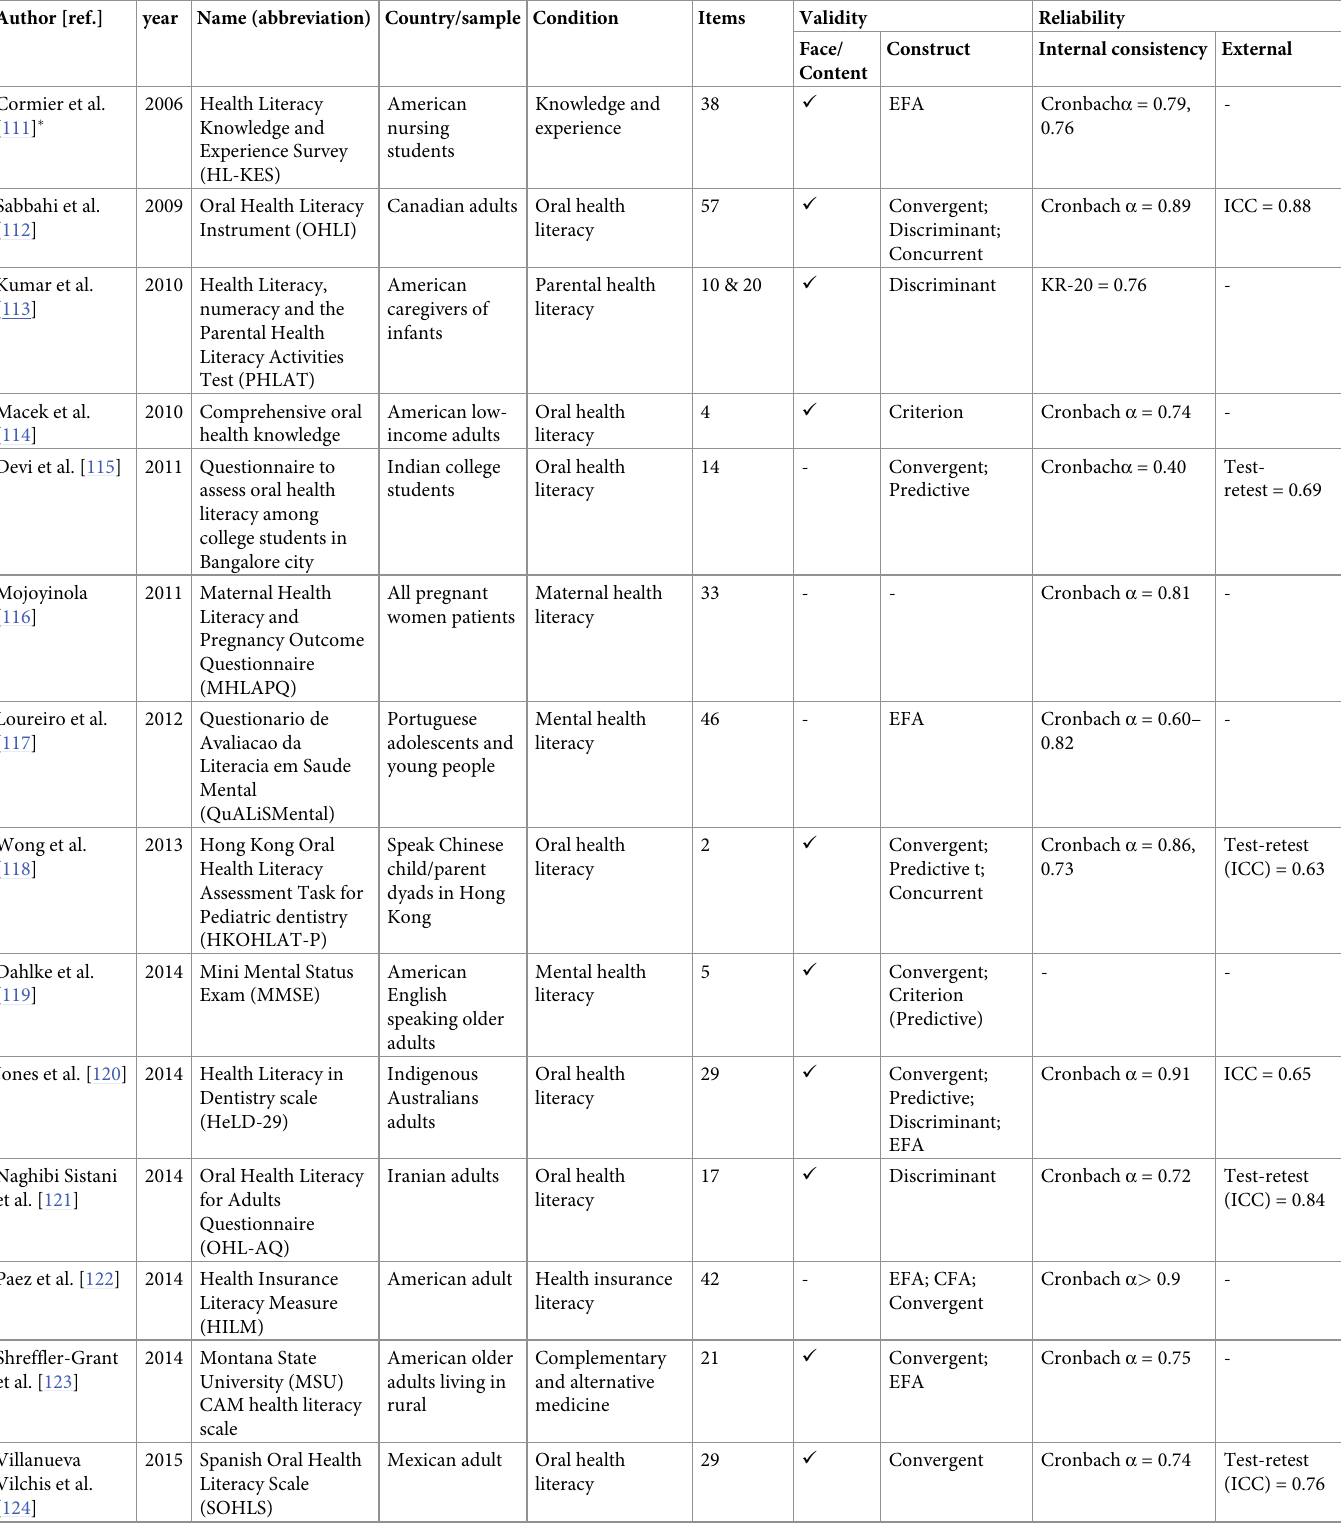
Table 4. Content specific health literacy instruments